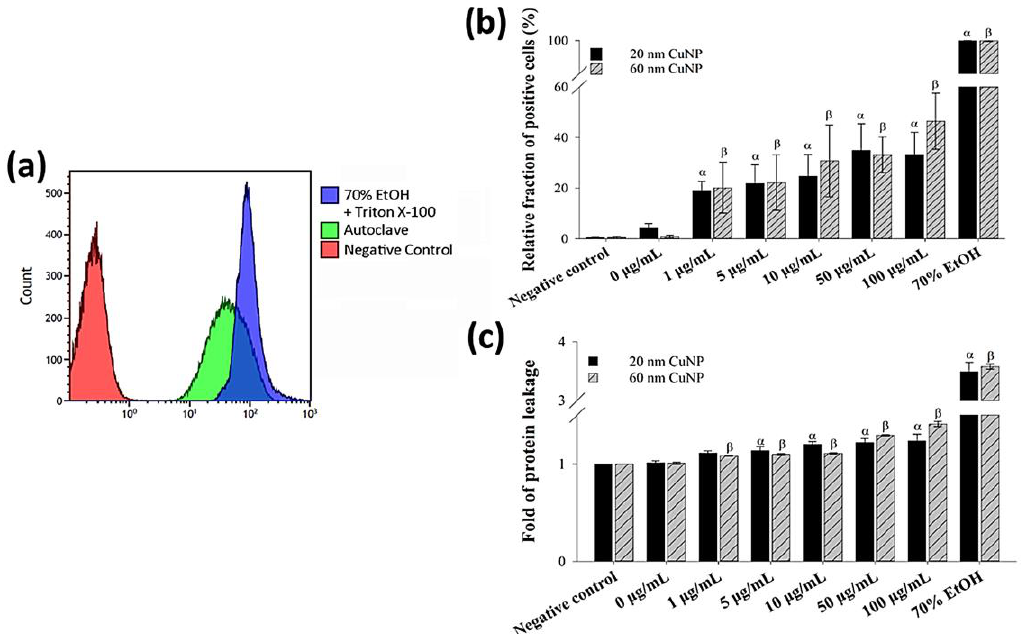
Figure 3. Membrane leakage detection in bacteria after being treated with two sizes of CuNPs in different concentrations for 24 h. ( a ) Flow cytometry profile of the bacterial population in control groups stained with PI dye. E. coli treated with PBS served as the negative control. E. coli treated with 70% alcohol plus triton X-100 or autoclaving served as positive controls. ( b ) Membrane permeability of E. coli. After CuNP treatment, PI staining was applied then analyzed using flow cytometry. ( c ) Cytoplasmic protein leakages in E. coli after CuNP treatment. Leaking proteins were collected from supernatants and detected by Bradford protein assay at an absorbance of 595 nm. Data are presented as mean ± SD from three independent experiments performed in triplicate for each treatment group. Statistical comparisons were performed by Student’s t -test; α and β indicate p < 0.05 for 20 and 60 nm CuNP treatments relative to negative control, respectively.